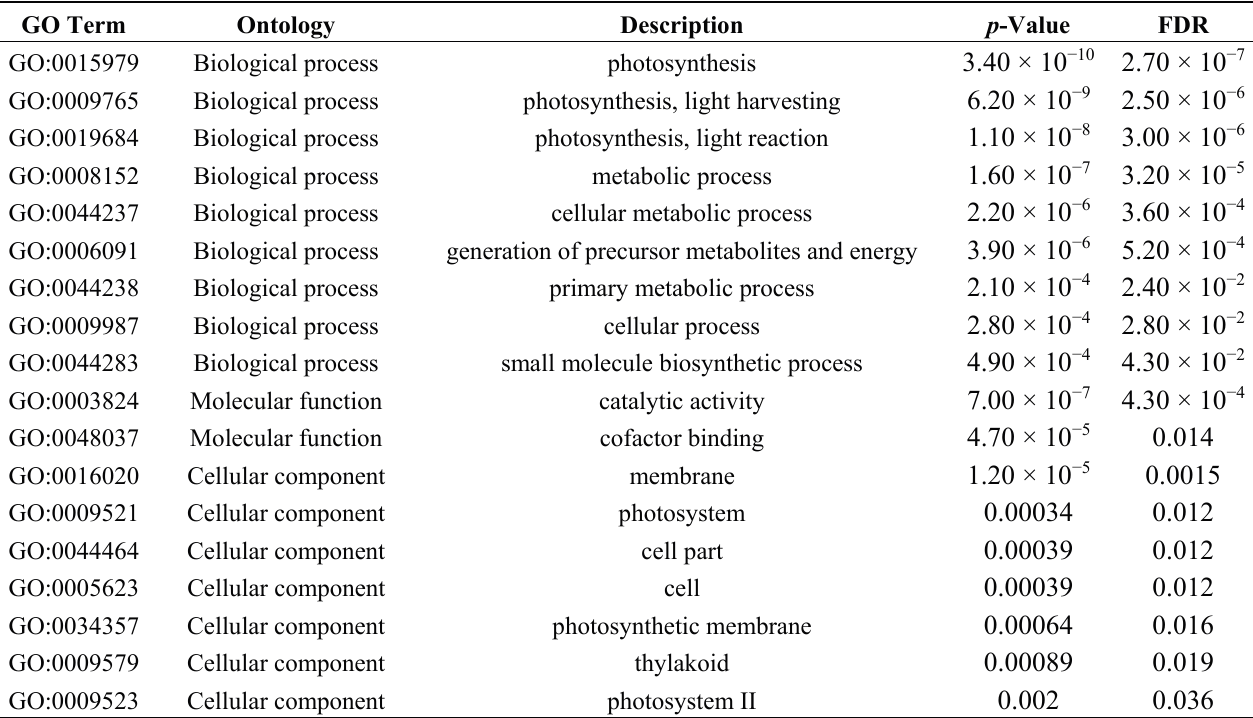
Table 1. GO enrichment results of the 1246 dwf1 -specific differentially expressed